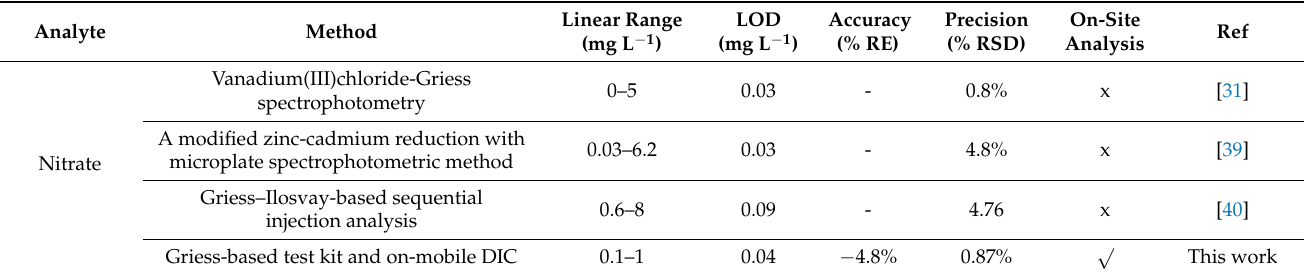
Table 2. Analytical performance comparison of developed method and other analysis